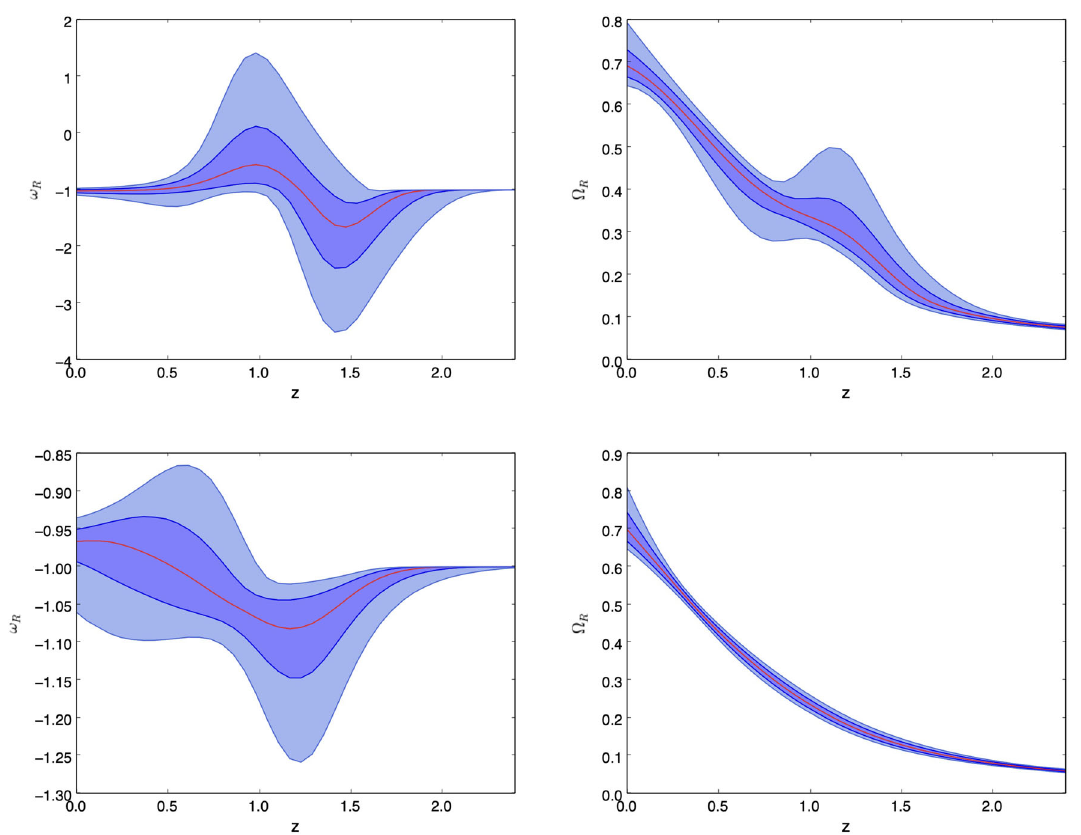
Fig. 3 The GP reconstruction of ω R and (cid:13) R for the 30 H ( z ) samples deduced from the differential age method, with 10,additional samples obtained from the radial BAO method (Table 1) is presented on the upper panel, when H 0 = 73 . 52 ± 1 . 62 km s − 1 Mpc − 1 has been merged to the expansion rate data used in the GP. The bottom panel corre- sponds to the GP reconstruction of the functions ω R and (cid:13) R , when H 0 = 67 . 40 ± 0 . 5 km s − 1 Mpc − 1 has been merged to the expansion ratedatausedintheGP.Thereconstructionhereobtainedisforthe f ( R )